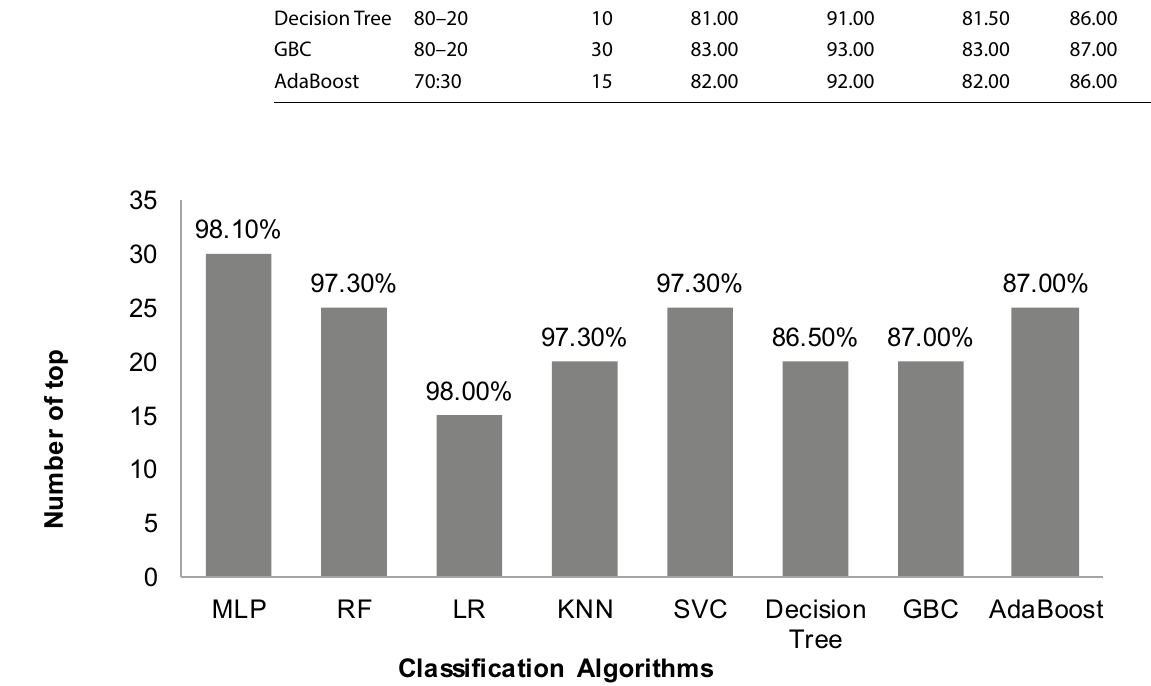
Fig. 11 Highest accuracy comparison on top suitable features of different classification algorithms